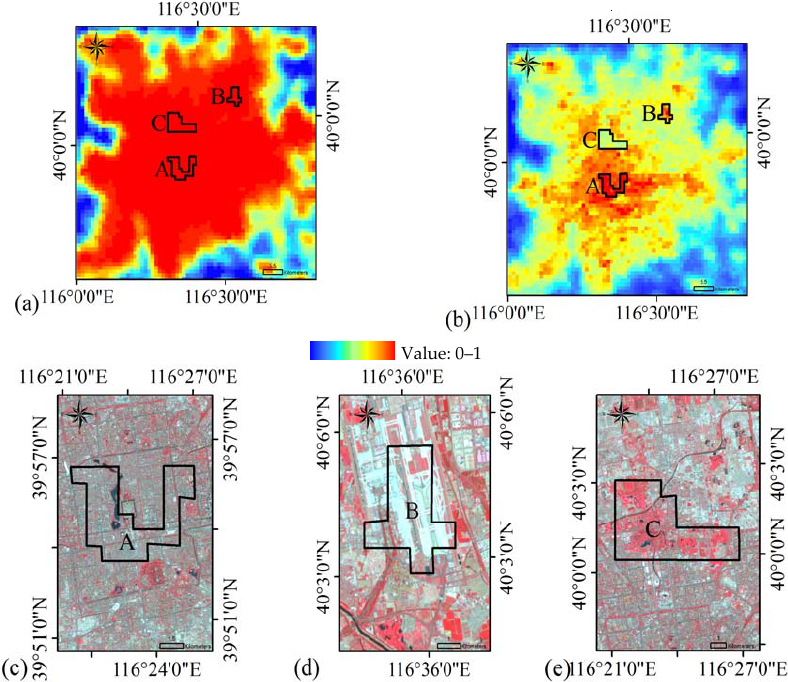
Figure 1. Raw Night Time Lights (NTL) image ( a ) and Land Surface Temperature (LST)-and-Enhanced Vegetation Index (EVI)-regulated-NTL-city index (LERNCI) result ( b ) of Beijing and corresponding Landsat 8 images with black boundary polygons. ( c ): A, Central business district (CBD) around the Forbidden City; ( d ): B, Beijing International Airport; ( e ): C, Beijing Olympic Forest